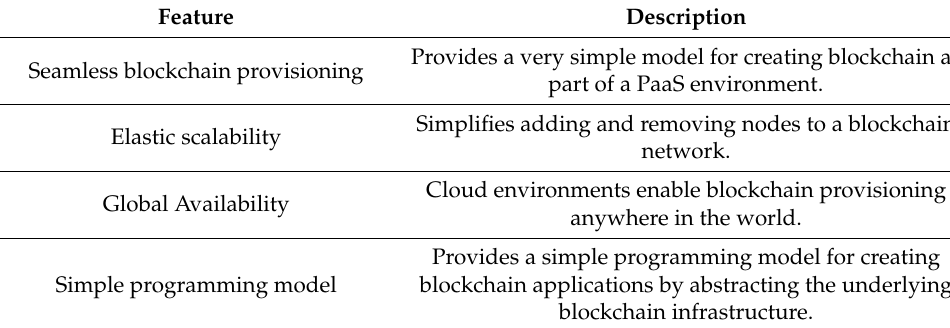
Table 2. Distributed cloud-based blockchain service features .